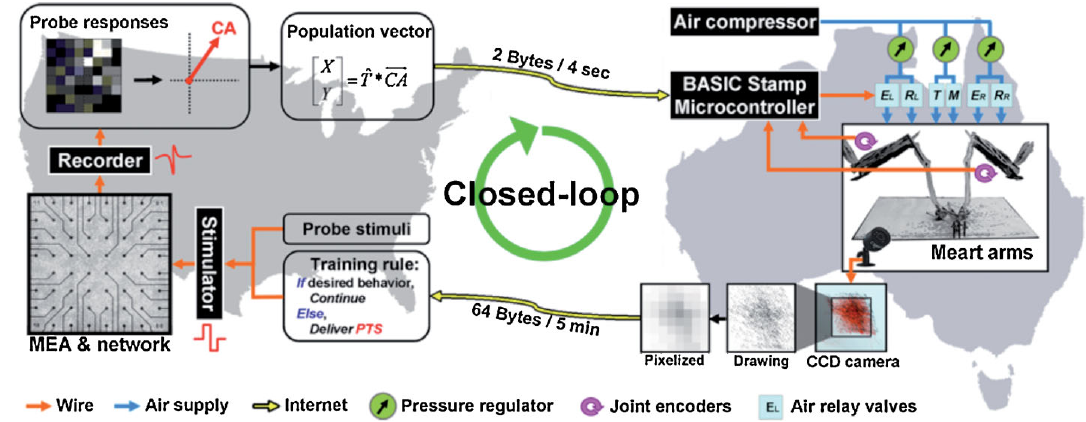
Figure 3. Schematicofthebio-roboticsoftwarealgorithmsandhardware,i.e.,MEART’scomponents . Commandingmovement: Thecenterofactivity(CA) of neuronal action potentials was calculated from 100ms of responses after a probe stimulation (8 × 8 box representing the MEA; increasing firing rate is black to white). Animat movement was instructed from a transformation ( ˆ T ) of the CA into a population vector. The [ X,Y ] movement command was sent over the internet